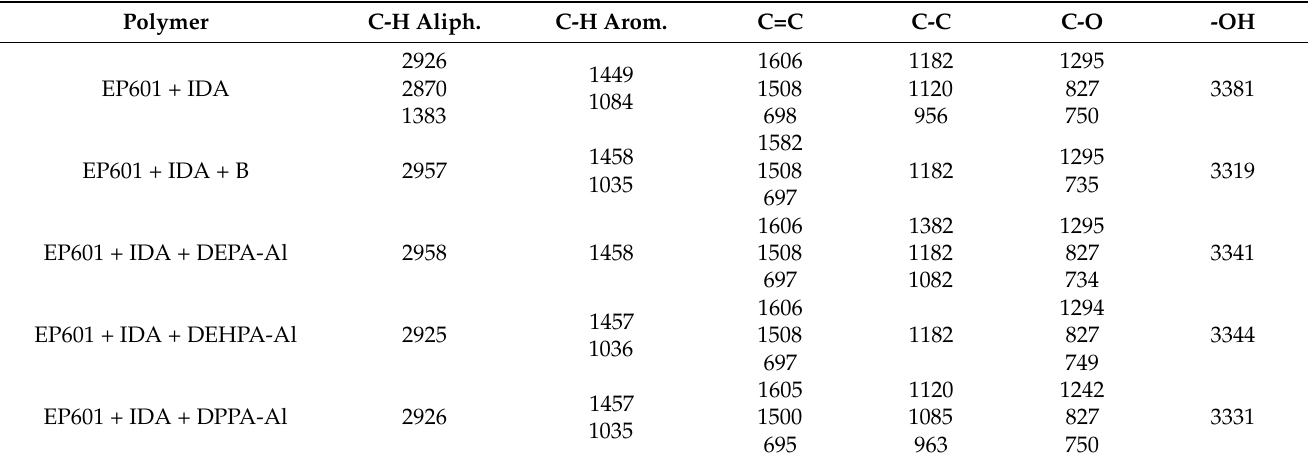
Table 5. TG data for hybrids in helium [cm − 1